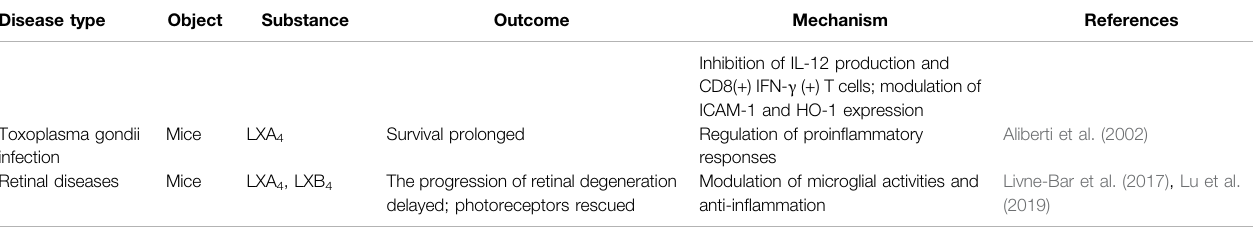
TABLE 2 | ( Continued ) Summary of in vivo studies on the neuroprotective effects of